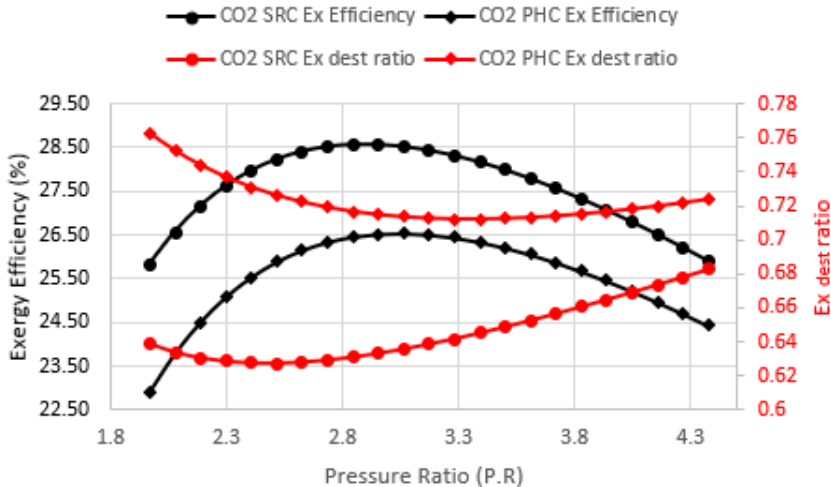
Figure 3. Exergetic efficiency and exergy destruction ratio of CO 2 SRC and PHC with respect to pressure ratio.